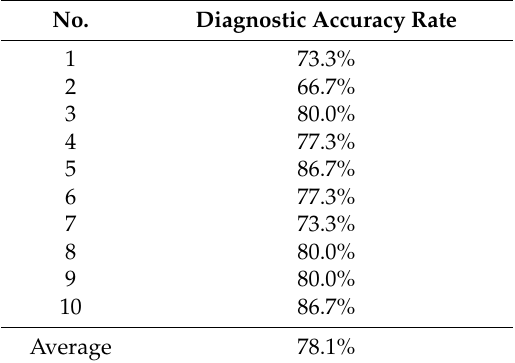
Table 5. Identification accuracy rate of 10 groups’ randomly chosen testing sets (IRFV).